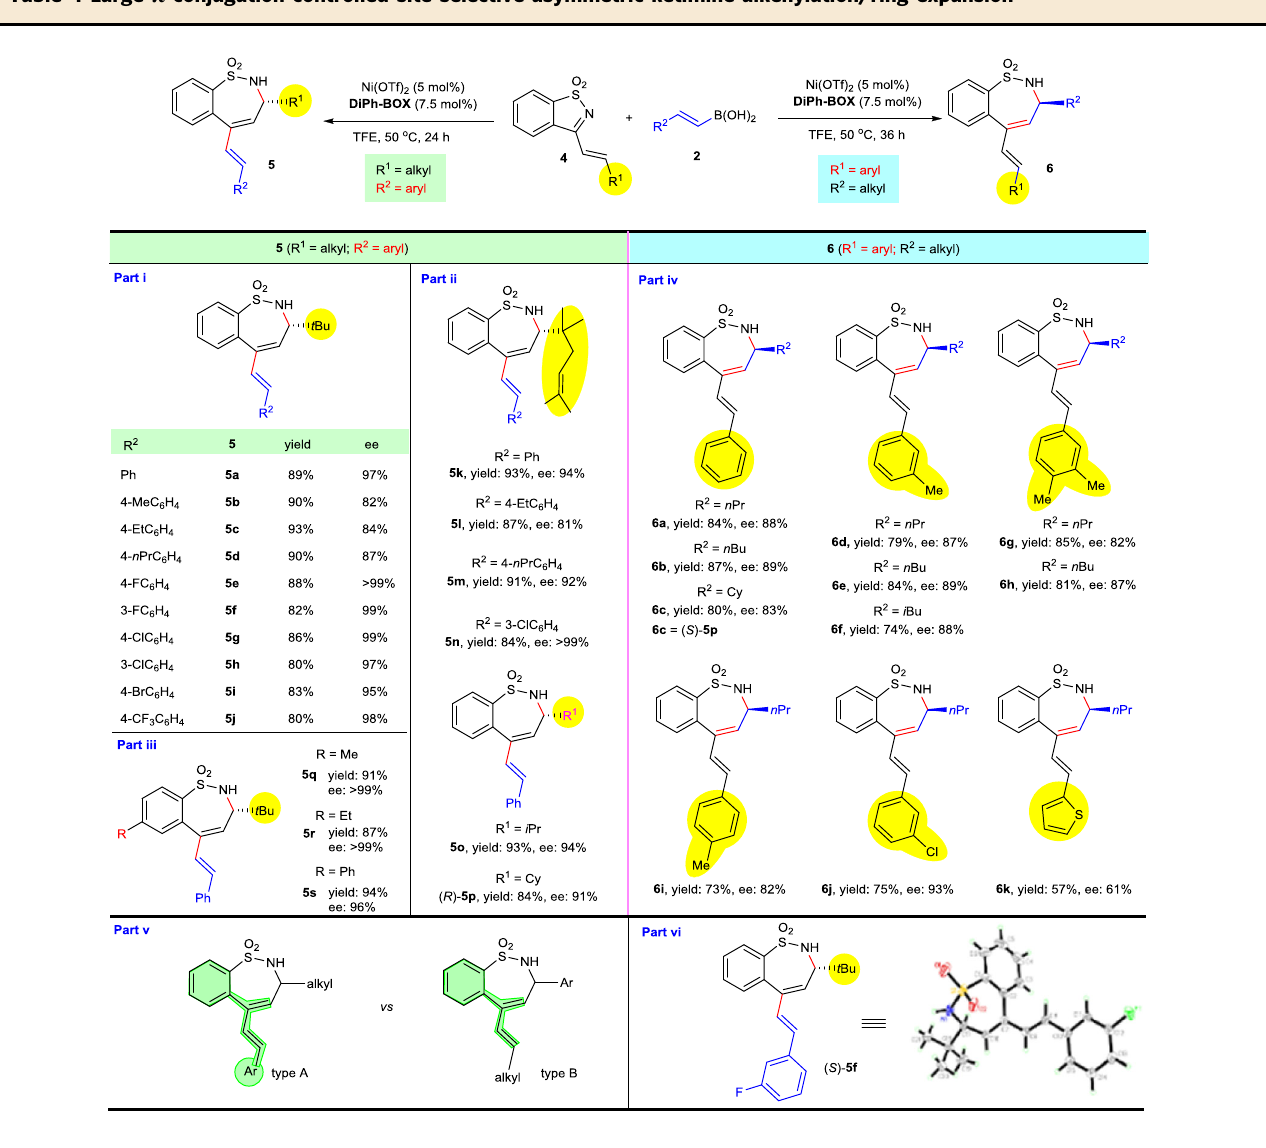
Table 4 Large π -conjugation-controlled site-selective asymmetric ketimine-alkenylation/ring-expansion